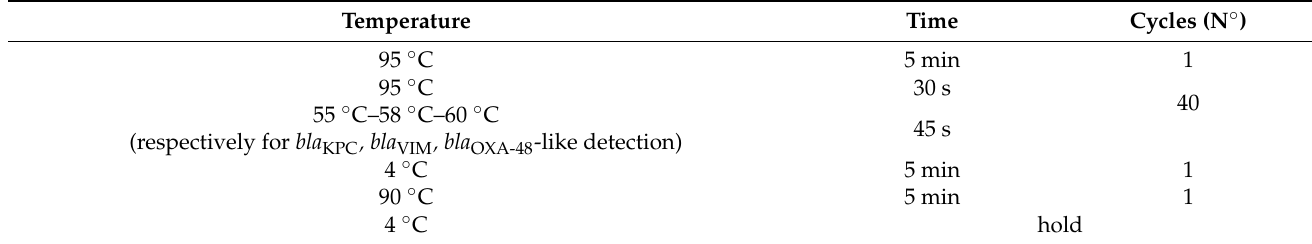
Table 2. ddPCR cycling protocol.